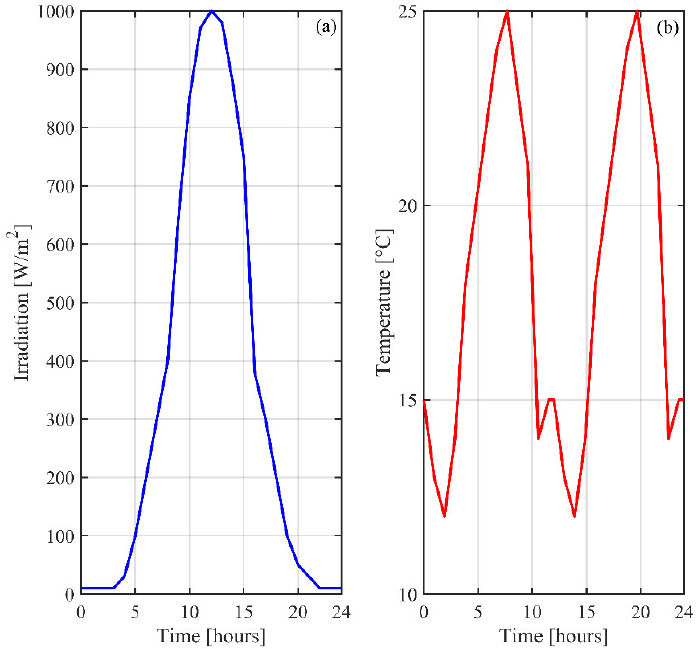
Figure 15. PV generator characteristics. ( a ) irradiation, ( b ) temperature.